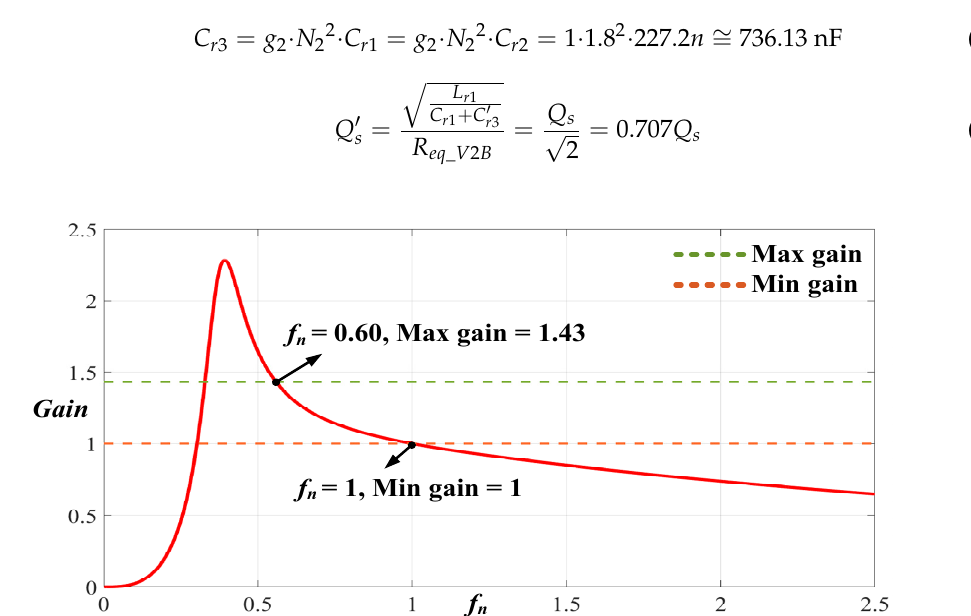
Figure 13. Voltage gain curve of the 2C3L resonant circuit when in V2G mode.